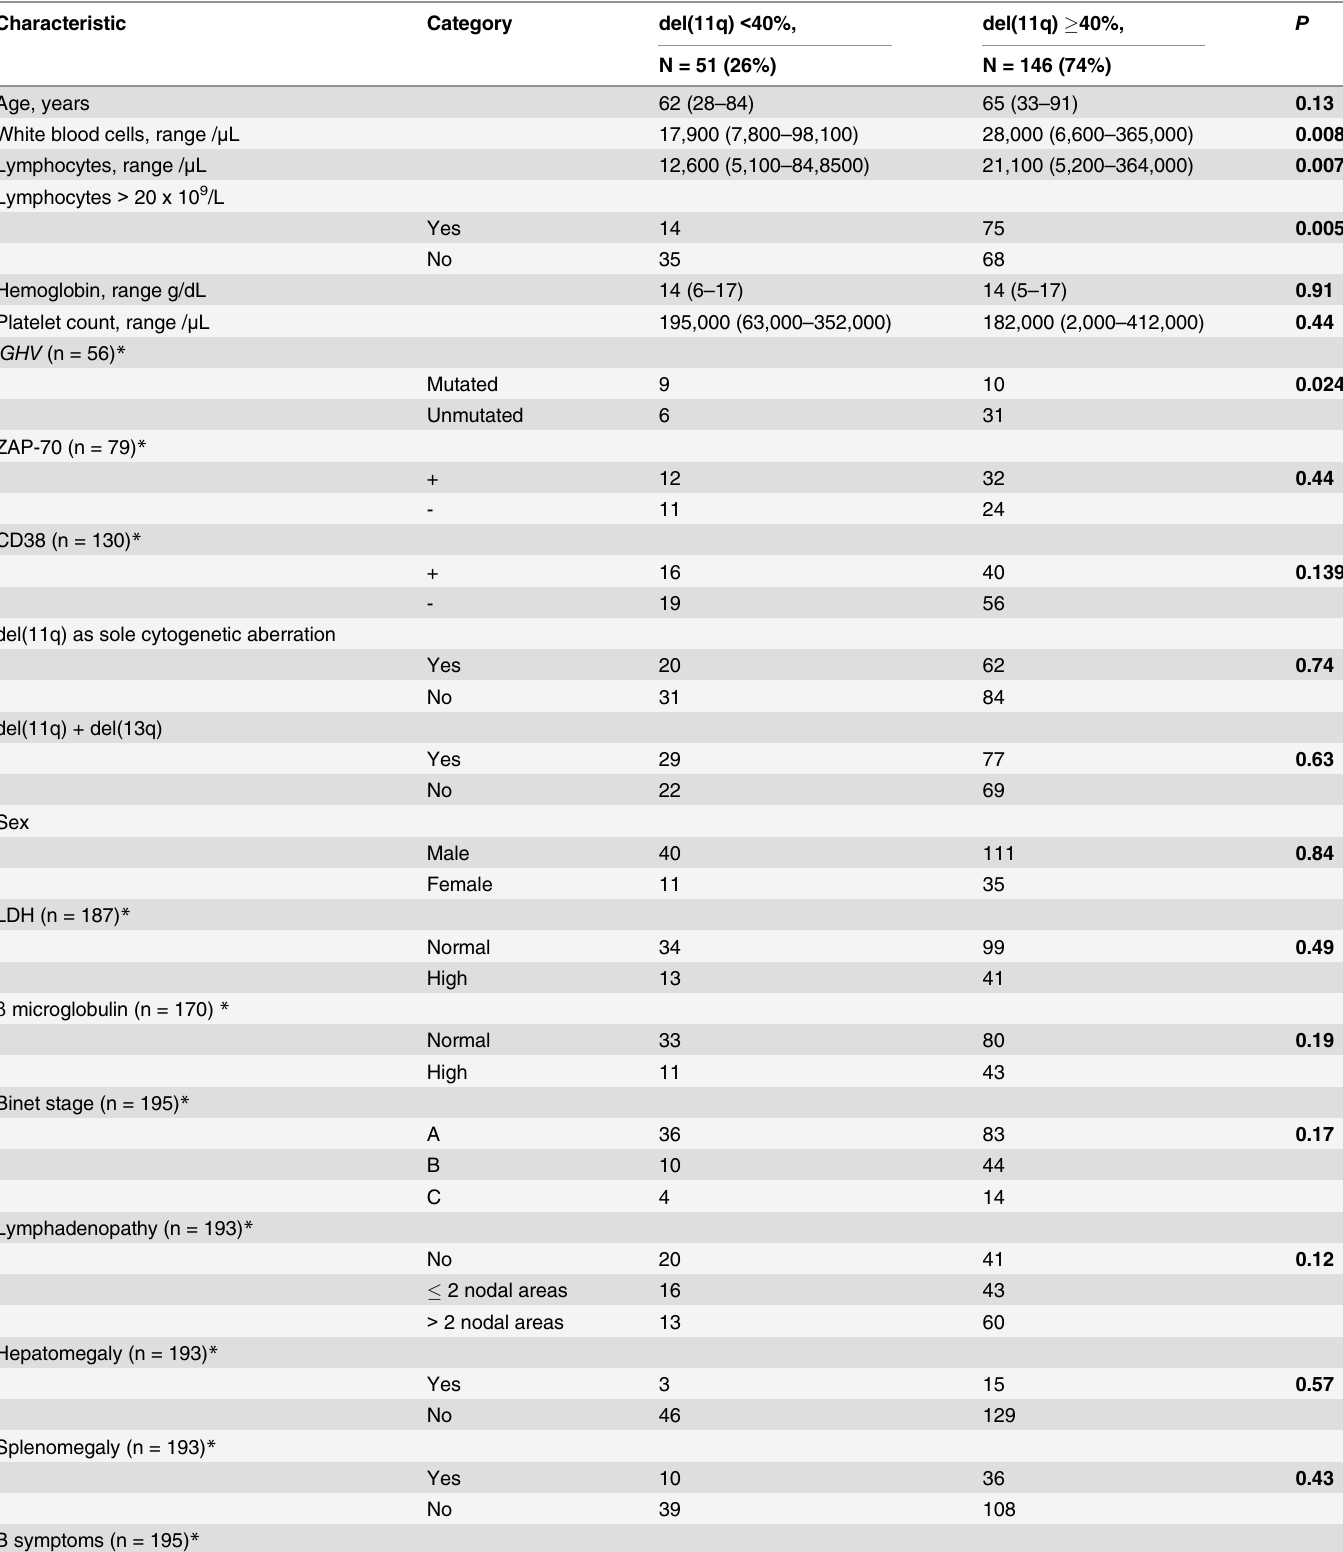
Table 1. Characteristics of 197 patients with 11q deletion with respect to the number of losses detected by FISH: < 40% (n = 51) or (cid:1) 40% (n =